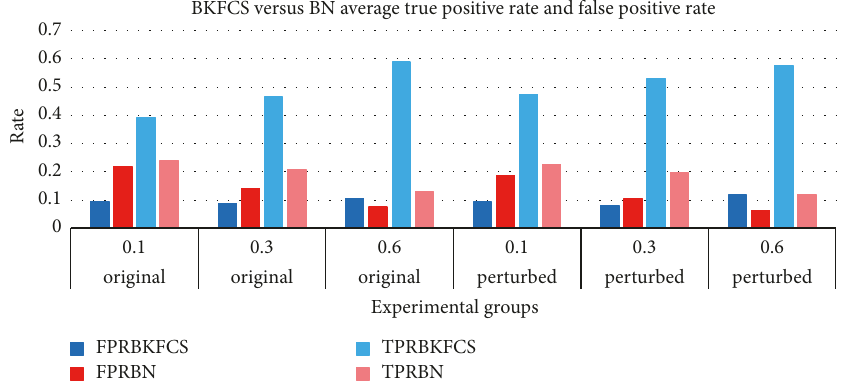
Figure 8: BKFCS versus BN average